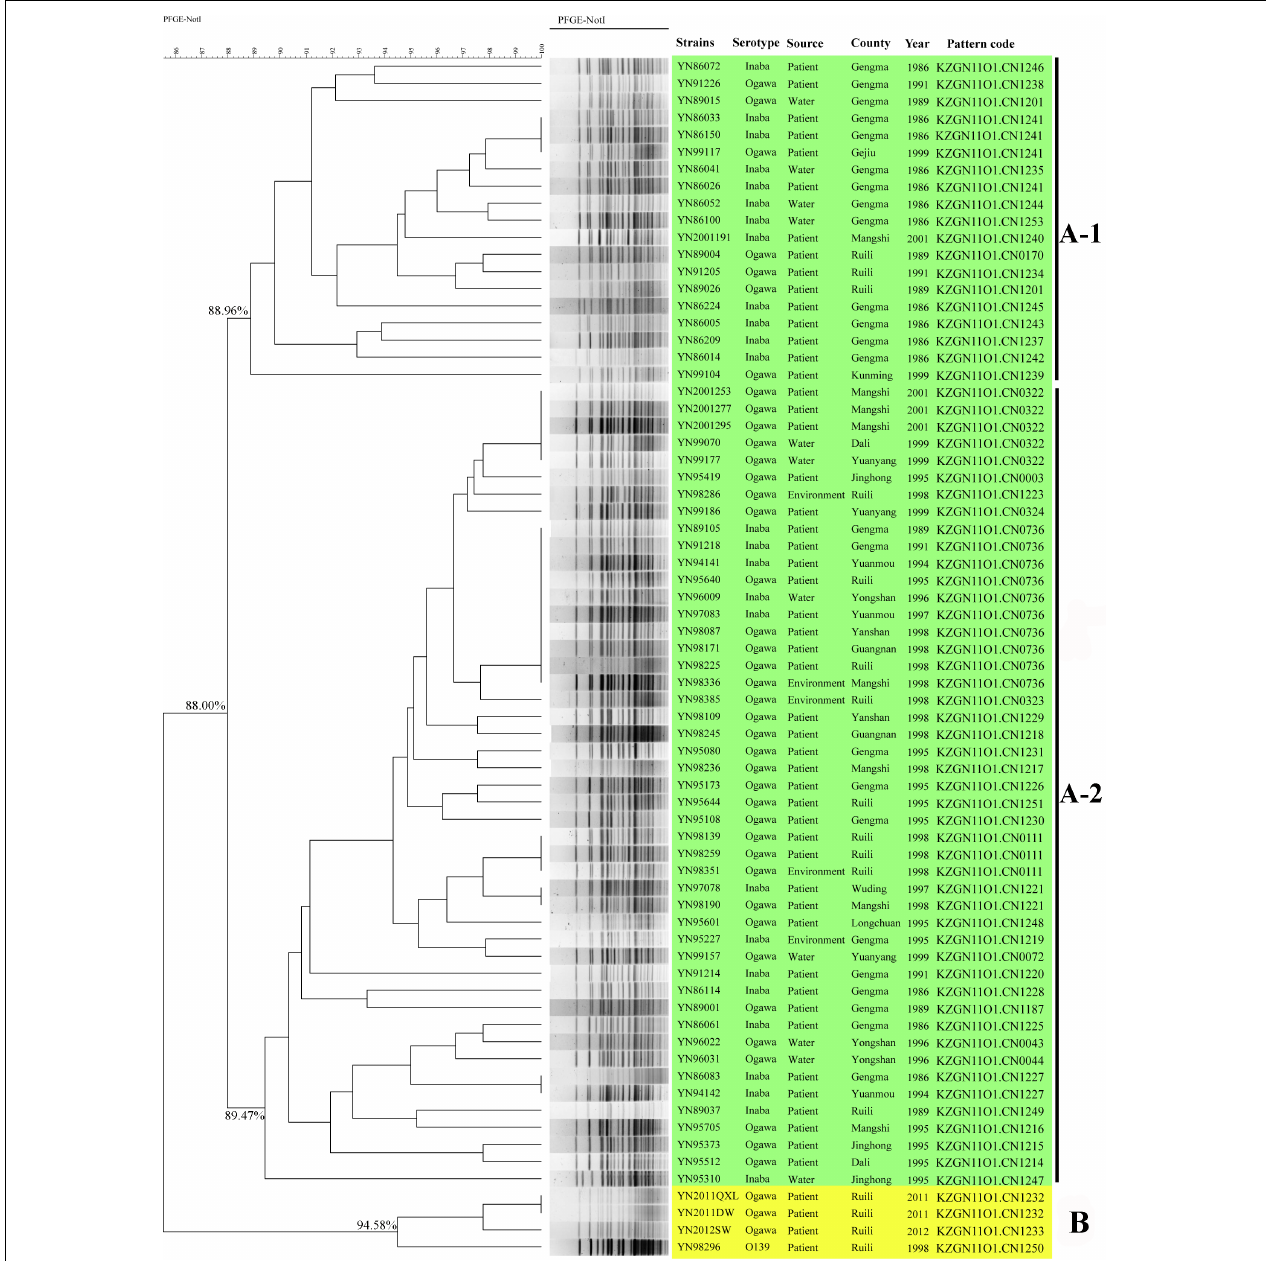
FIGURE 1 | PFGE- Not I dendrogram for 70 V. cholerae in this study. The green areas of group A mainly referred to native epidemic strains, while the yellow areas of group B were mostly imported strains from Myanmar.